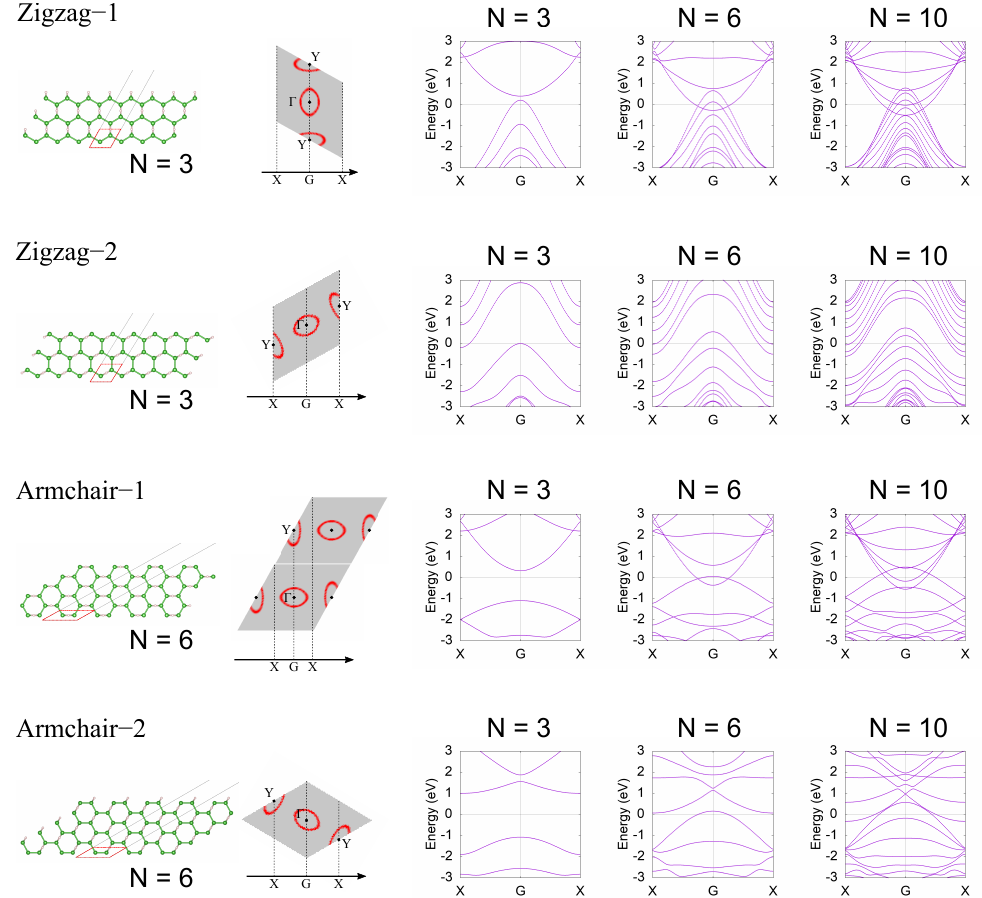
Figure 4. HB nanoribbon and its electron structure. Red cells in lattice structure figures are the unit cells that construct the nanoribbon. In each row (each truncation type), the definition of the 1D BZ is shown with the 2D BZ (gray shaded rhombus) in the second right figure. For four edge truncation types, electron band structures of nanoribbons are calculated for a three-unit cell case ( N = 3), a six-unit cell case ( N = 6), and a ten-unit cell case ( N =